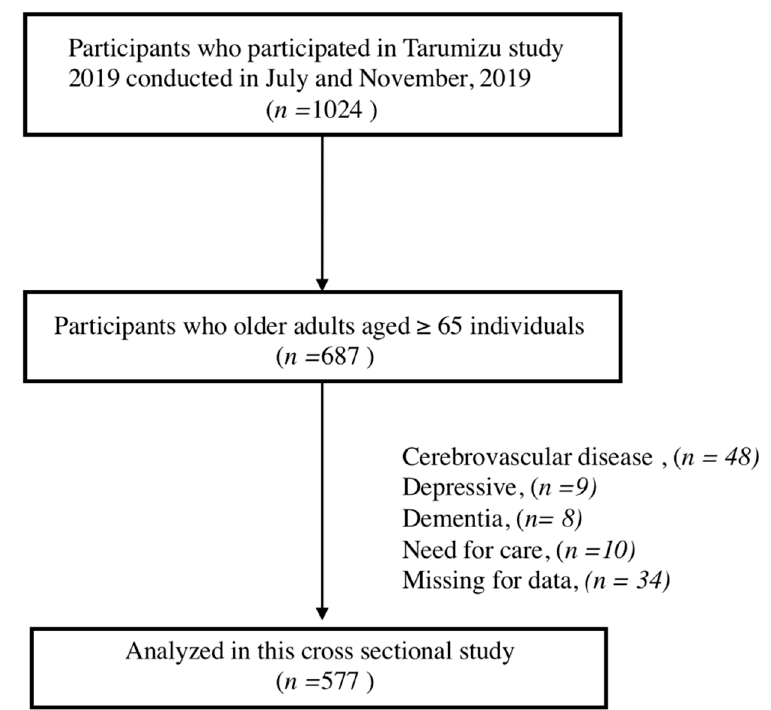
Figure 1. Participant inclusion criteria flow